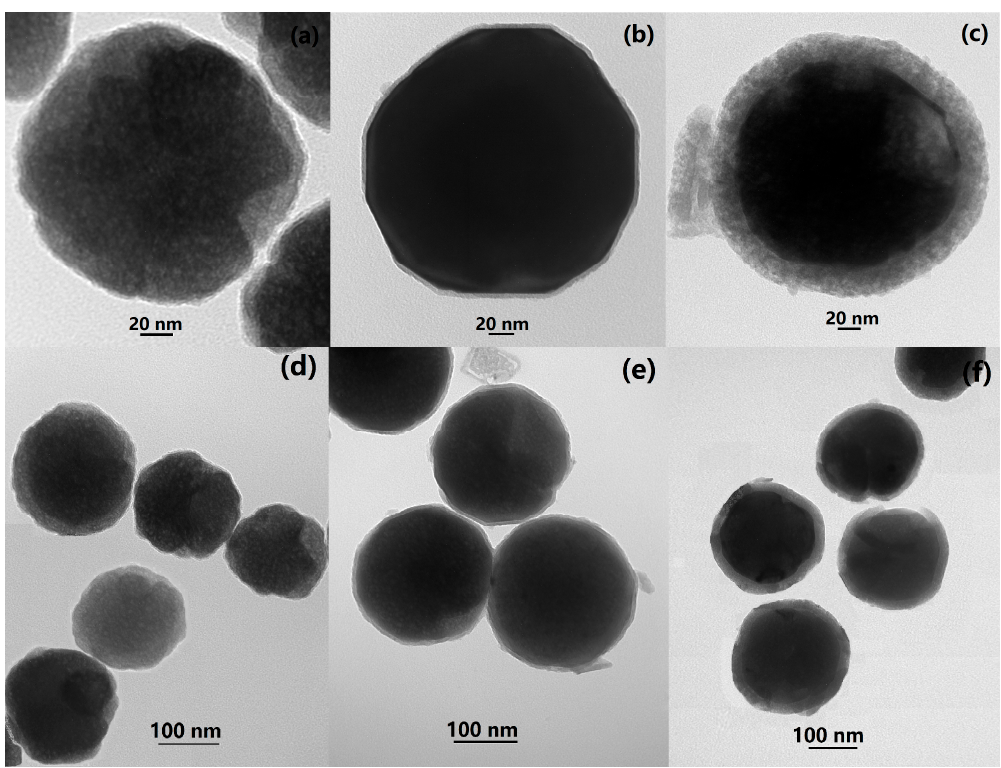
Figure 1. TEM images of ( a , d ) Fe 3 O 4 nanoparticles, ( b , e ) Fe 3 O 4 /SiO 2 core-shell